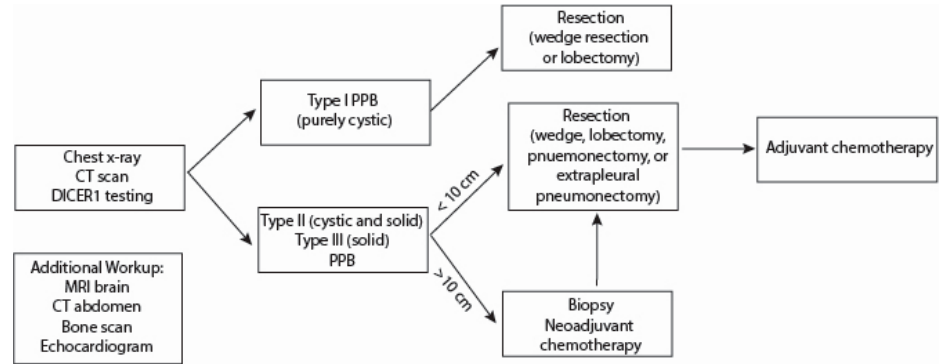
Figure 2. Proposed management algorithm based on type and complexity of PPB. Note: Type I PPB